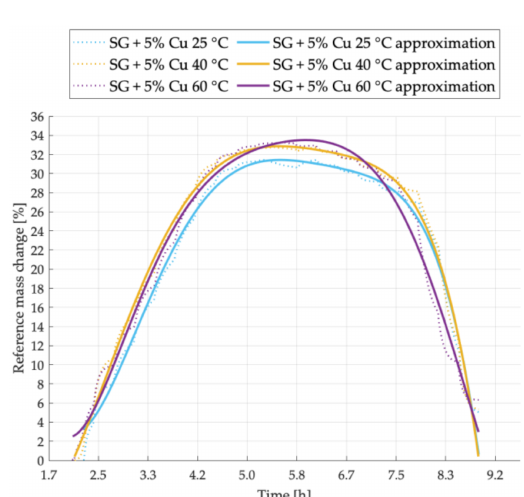
Figure 7. Sorption kinetics graph for SG + 25% CNT sample tested at temperatures of 25 ◦ C, 40 ◦ C, 60 ◦ C.